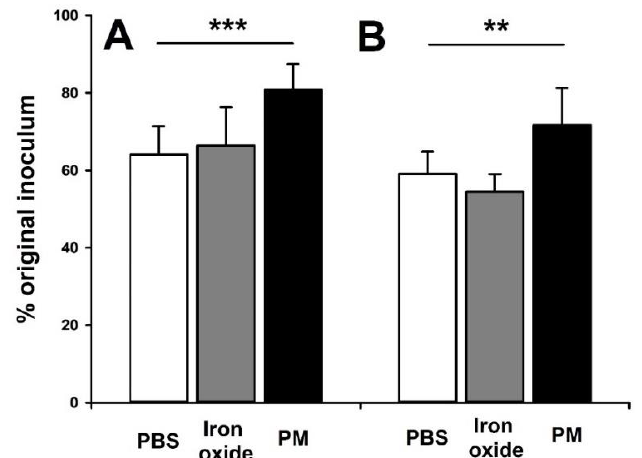
Figure 1. Adhesion (panel A ) and invasion (panel B ) of non-typeable Haemophilus influenzae (86-028NP strain; NTHi) in bronchial epithelial cells (NuLi-1) three hours after exposure to 10:1 MOI of the bacteria. Prior to bacterial exposure, cells were exposed to either media alone (white bars), 10 µg/mL of iron oxide particles in media (grey bars) or 10 µg/mL of community sampled particulate matter (PM) 10 in media (black bars) for 24 h. Data are presented as mean (SD). *** indicates p < 0.001 and ** indicates p < 0.01. PM 10 exposure enhanced both NTHi adhesion to and invasion of NuLi-1 cells while control particles (iron oxide) had no effect.